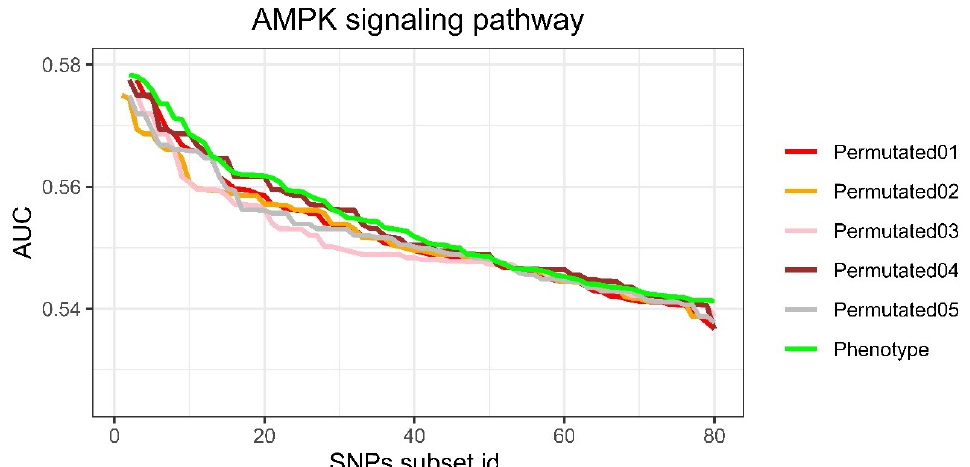
Figure 9. AUC values of the 80 iterations performed for the AMP-activated protein kinase (AMPK) signaling pathway in the case of cases and controls (phenotype) and five different permutations.